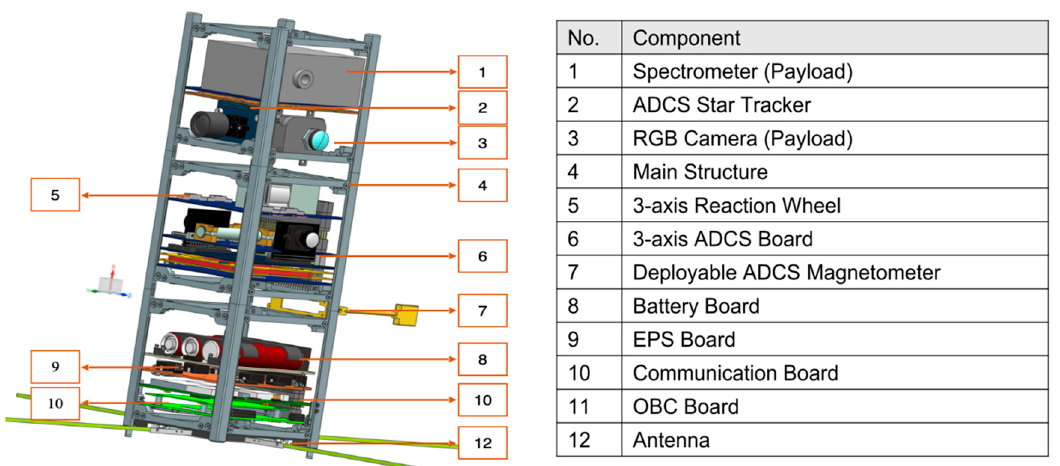
Figure 16. MeznSat internal system layout.